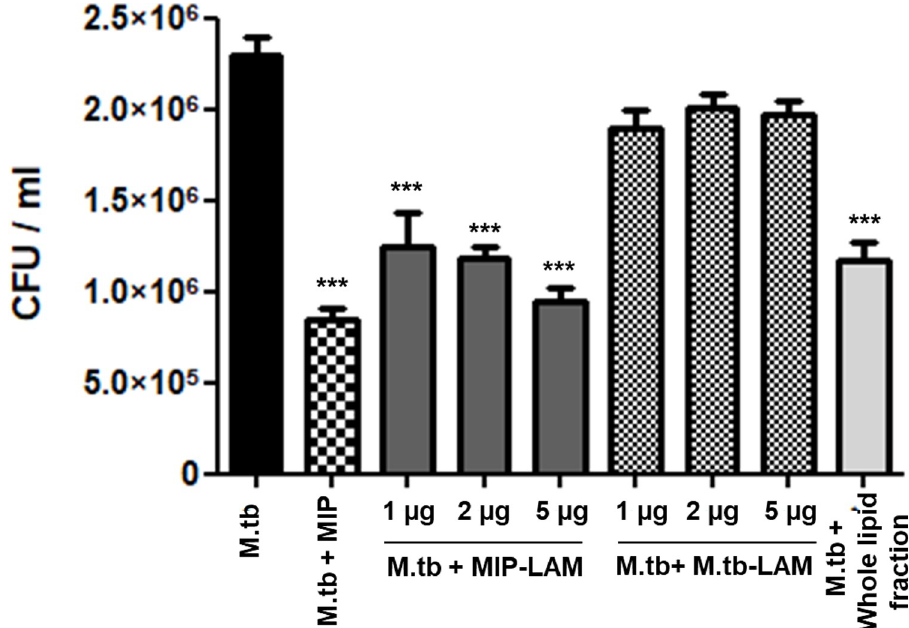
Fig 5. MIP-LAM stimulation leads to enhanced clearance of M . tb from infected macrophages. Macrophages were infected with GFP expressing M . tb for 4 h and subsequent stimulation with varying concentrations of MIP-LAM/ M . tb- LAM for 4 h. Group stimulated with MIP whole lipid fraction was taken for comparison. Cells lysate was prepared and plated (100 μ l from each group) in triplicates on 7H11-agar plates. Shown here is the mean CFU count of M . tb from 4 independent experiments. ��� : P <